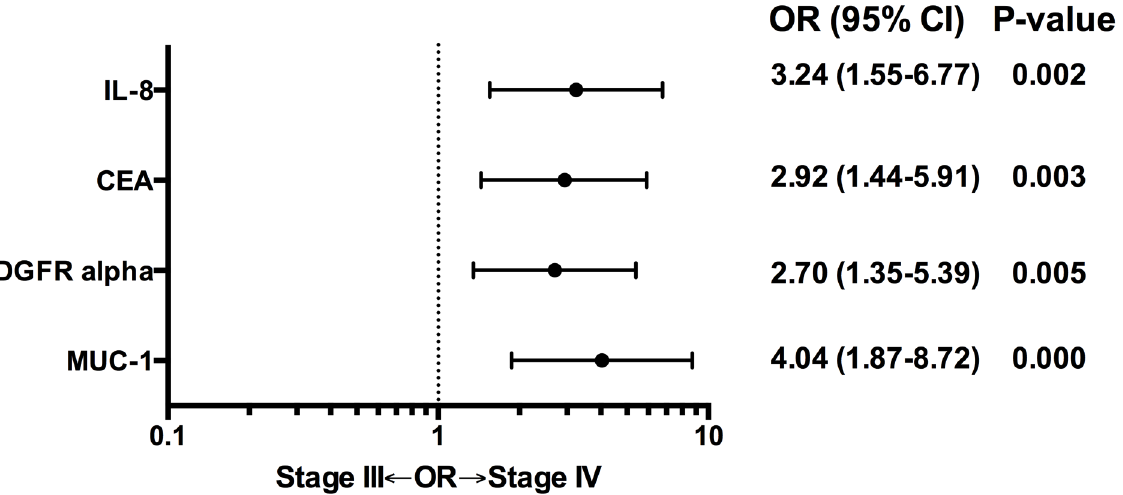
Fig 2. Odds ratios (OR) of having stage III disease (locally advanced) for biomarker concentration, according to median levels (low vs. high). ORs and p-values are shown for biomarkers that were significantly associated (p < 0.05). Results shown are from the validation cohort.